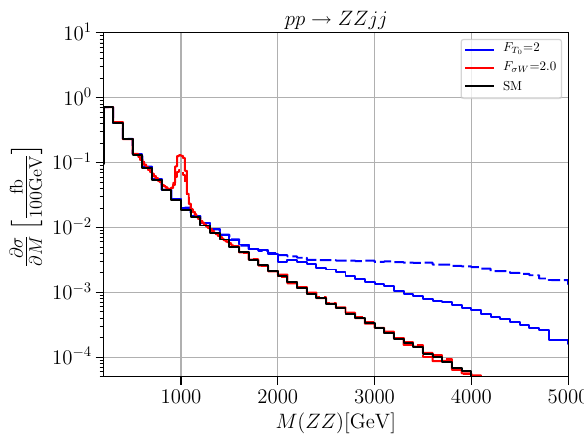
Fig. 5 Cross sections differential in the diboson invariant mass for the process pp → Z Zjj . The solid black line shows the Standard Model, the blue lines show an anomalous coupling F T lines show a scalar resonance with mass m σ = 1TeV and coupling of F σ W = 2 . 0 TeV − 2 . Solid: unitarized; dashed: naive result. Cuts: M jj > 500 GeV, Δη jj > 2 . 4, | η j | < 4 . 5, p j